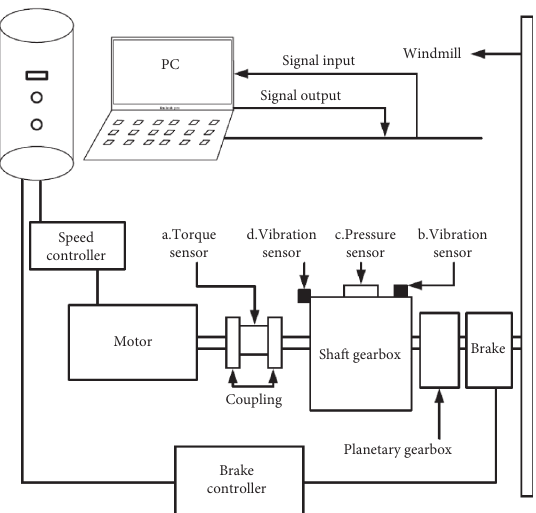
Figure 6: The operation diagram of